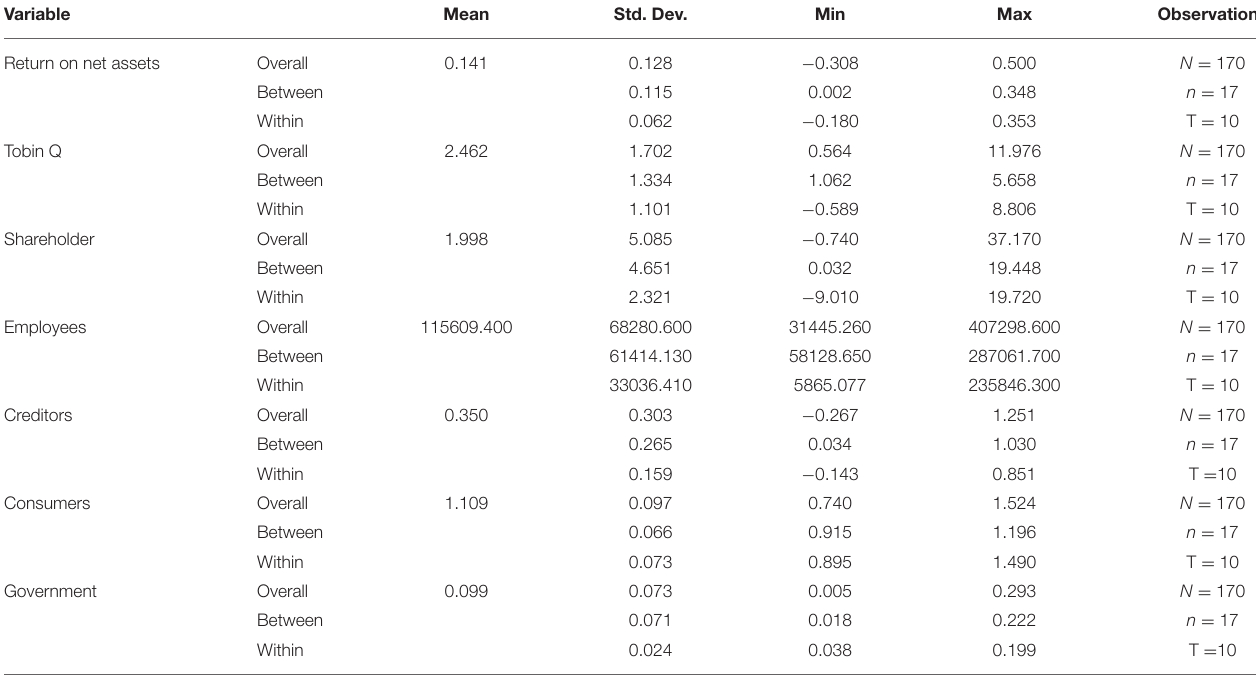
TABLE 2 | Results of descriptive statistics of variables. Variable